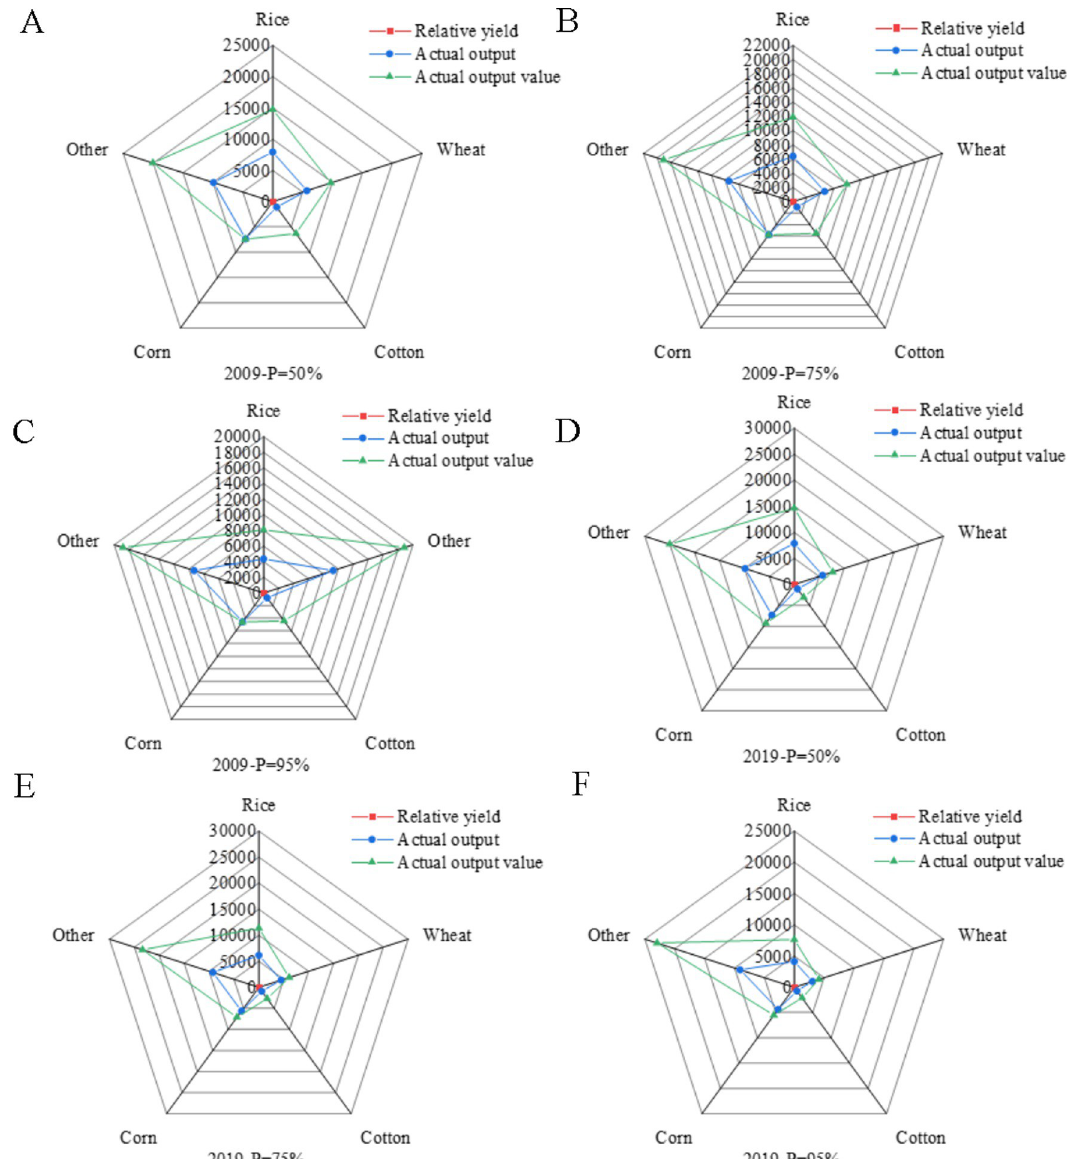
Fig 9. Benefit analysis of water resource allocation for different crops, stages, and